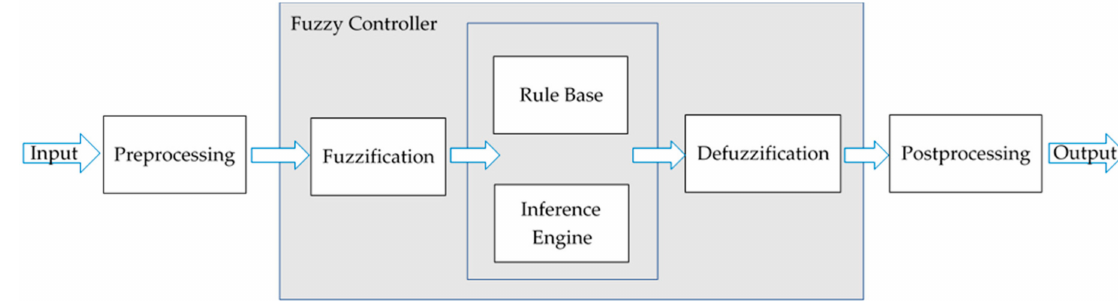
Figure 11. The structure of the fuzzy controller.